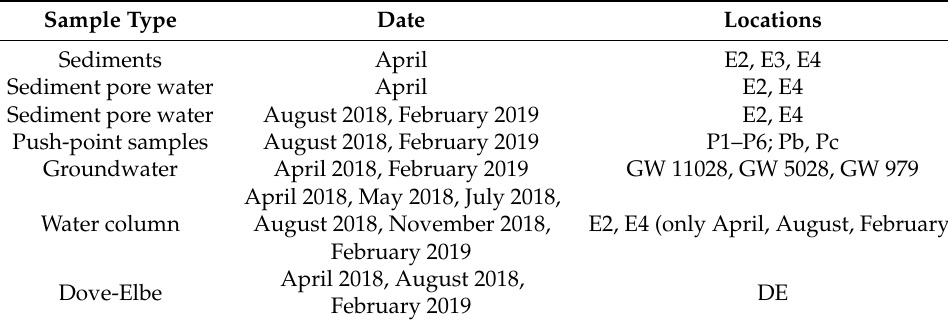
Table 1. Sample types, sampling campaigns, and